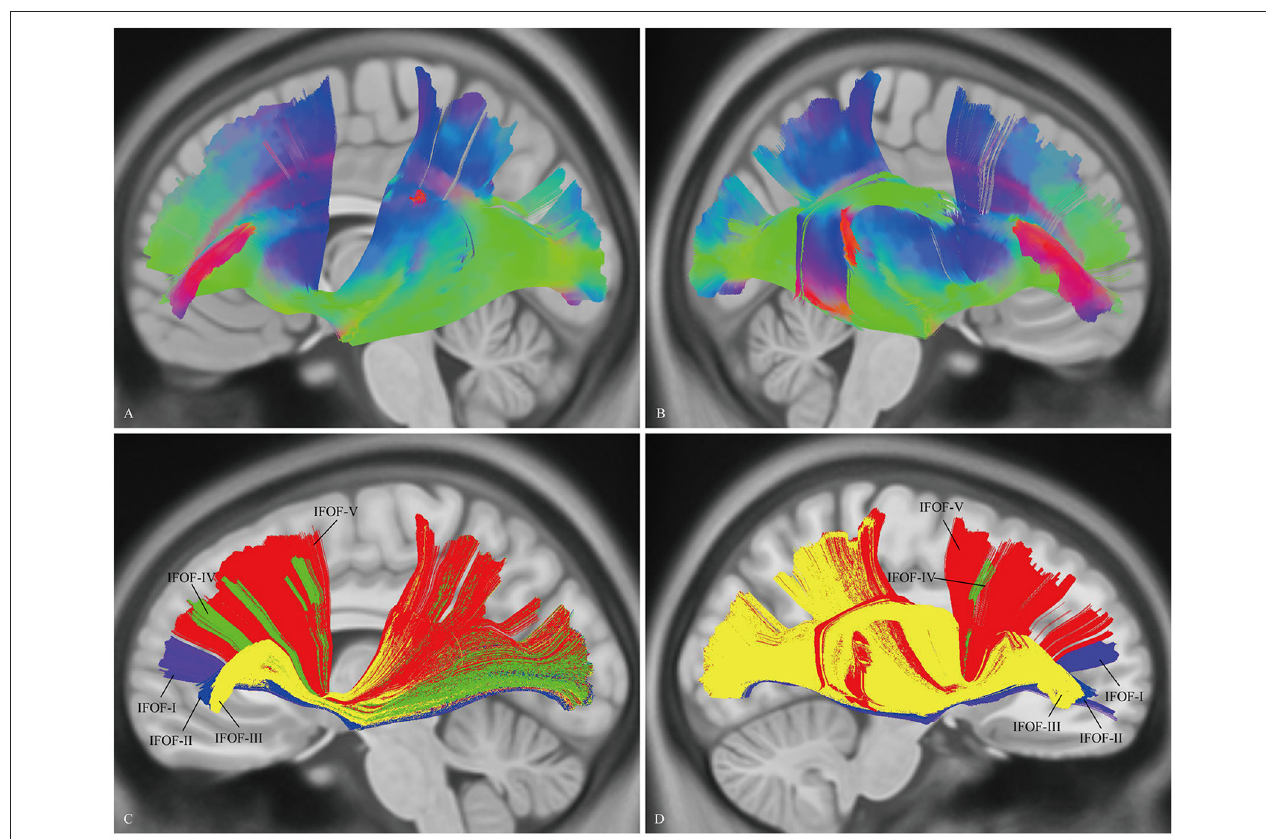
FIGURE 3 | In vivo fiber tractography of the IFOF on the DSI template. (A,B) The NTU-90 showed an extended pattern compared with the subject-specific results. (C,D) A consistent pattern of five segmentations was confirmed within both hemispheres of the template. L, left; R,